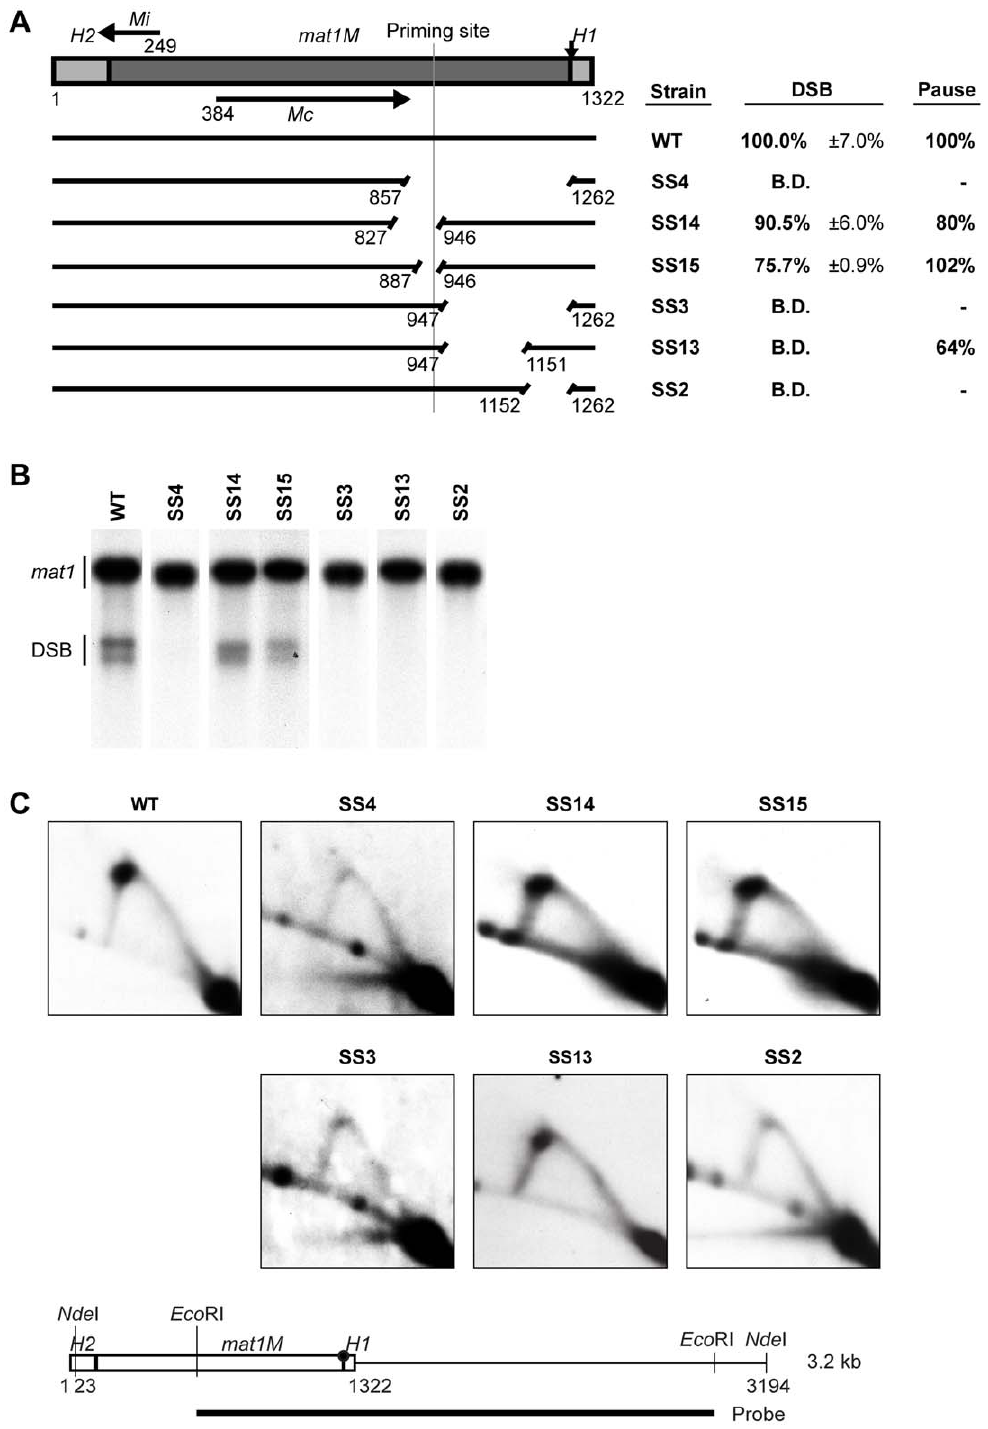
Figure 2. Identification of two regions required for imprinting and pausing within the mat1M cassette. (A) Line drawing on the left, a simple representation of the intact mat1M cassette flanked with the homology domains is shown. The site of the imprint is indicated by a vertical arrow. The nucleotide length of the region is given. The positions of the two encoded transcripts, Mi and Mc , are shown by horizontal arrows. The full- length wild-type DNA is represented by an intact line, whereas deletions are shown as gapped lines and the nucleotide positions of the start and the end of each deletion are given below the lines. The position of the specific lagging-strand priming site described in 12] is marked by a vertical line. The text box on right shows the names of the strains used, followed by quantification of the double-strand break (DSB) products (including standard error) and of the replication pause signal observed on 2D gels. The results are given as percentages of the wild-type values (100%). For DSB products, the values lower or equal to the negative control threshold are indicated as ‘‘below detection’’ (B.D.), whilst the absence of a pause signal is indicated by a dash. (B) Southern analysis of the strains shown in panel A. Genomic DNA was digested with Hind III and probed with the mat1P Hind III fragment. During DNA isolation, the imprint is hydrolyzed to a DSB and the resulting break products migrate as two bands. The strain names are given on top,